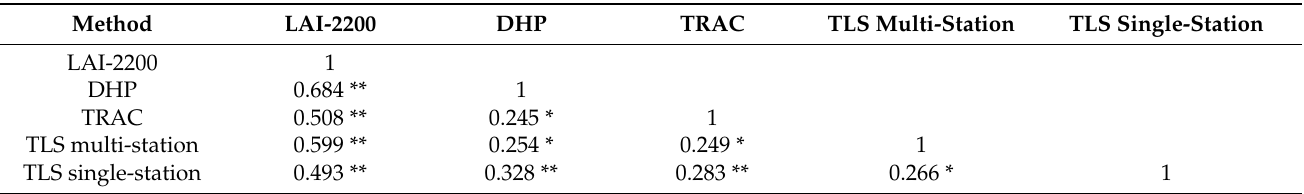
Table 2. Correlation coefficients of estimating the effective LAI by different indirect methods.